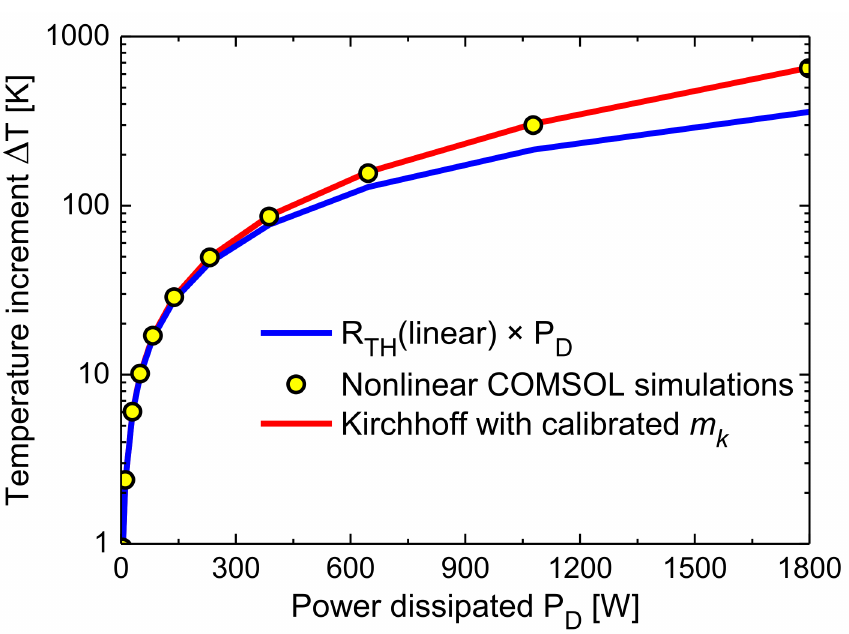
Figure 5. Temperature increments vs. power P D dissipated by the heat source. Comparison be- tween nonlinear FEM simulations (yellow dots) and values obtained with the calibrated Kirchhoff’s transformation (red curve). The graph also reports ∆ T lin given by the product of the linear thermal resistance value (R TH ) and P D (blue curve).